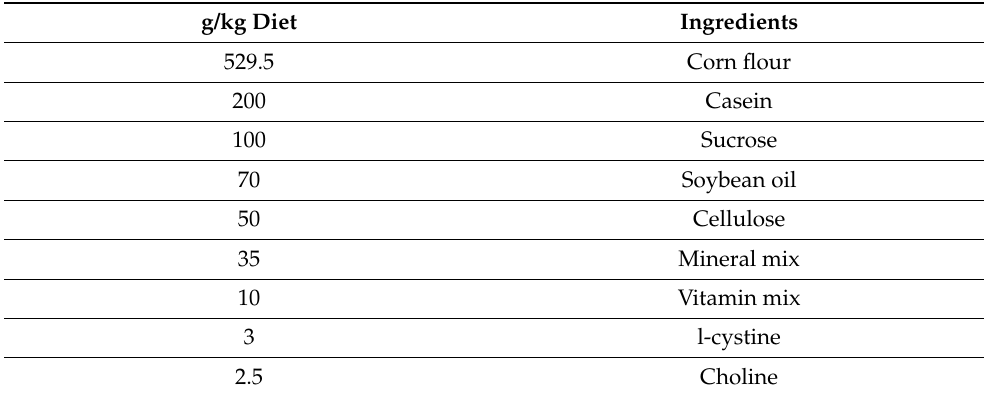
Table 1. Ingredients of the basal